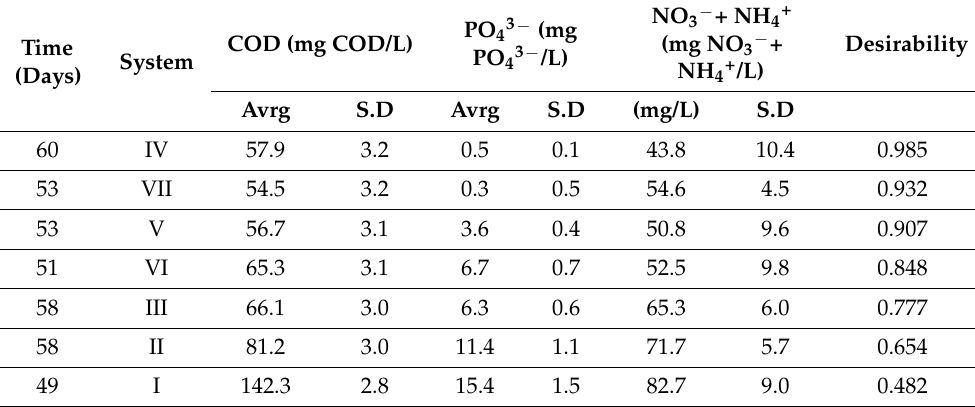
Table 5. Ranking of systems performance based on desirability indices. Avrg stands for average, and S.D for standard